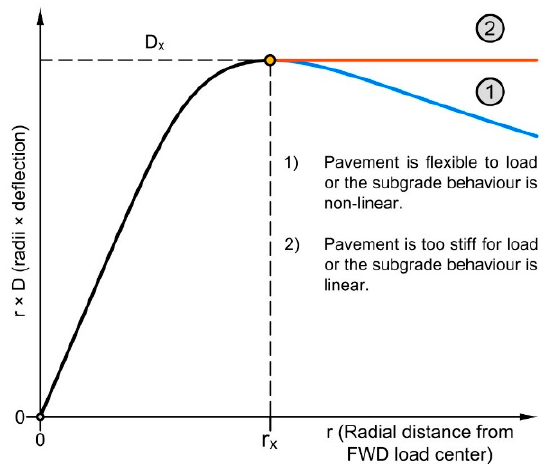
Figure 6. Radii vs. radii × deflection plot of the deflection bowl.